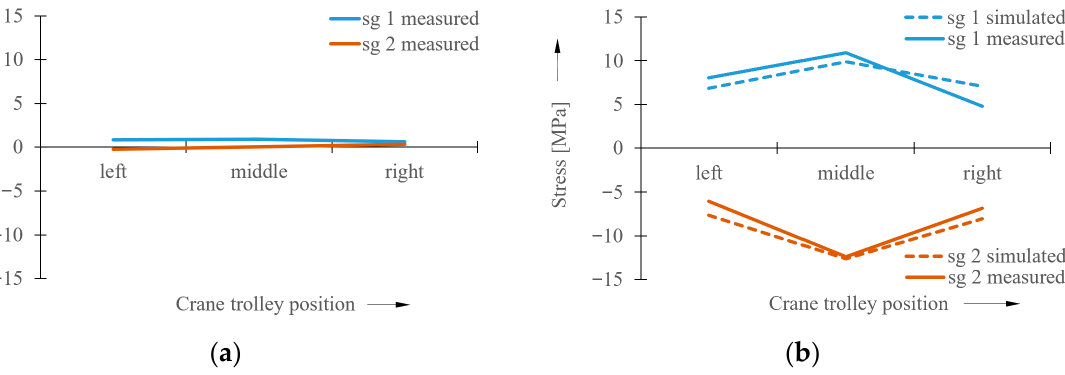
Figure 12. Experimentally measured stress values in crane bridge structure. ( a ) without crane skewing, ( b ) with forced crane skewing.